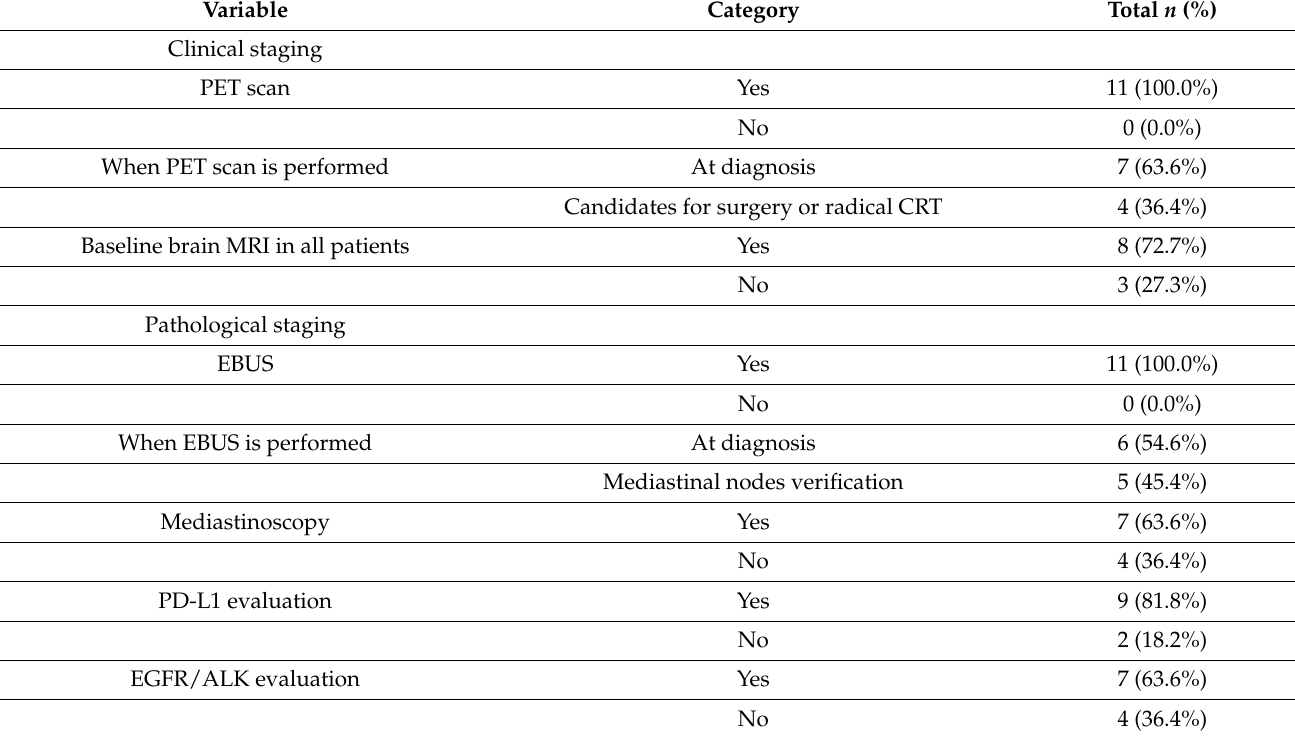
Table 1. Current practices for stage III NSCLC staging.